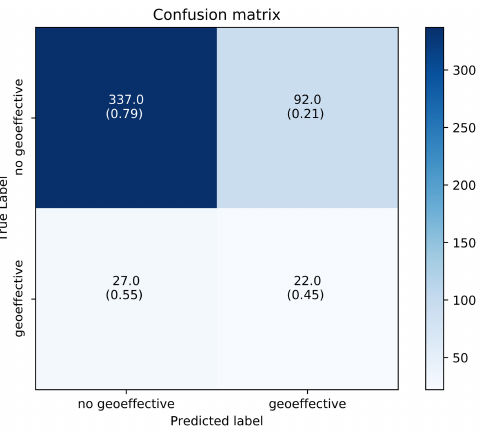
Figure 7. The confusion matrix of the geoeffectiveness prediction results of our method on the testing set.